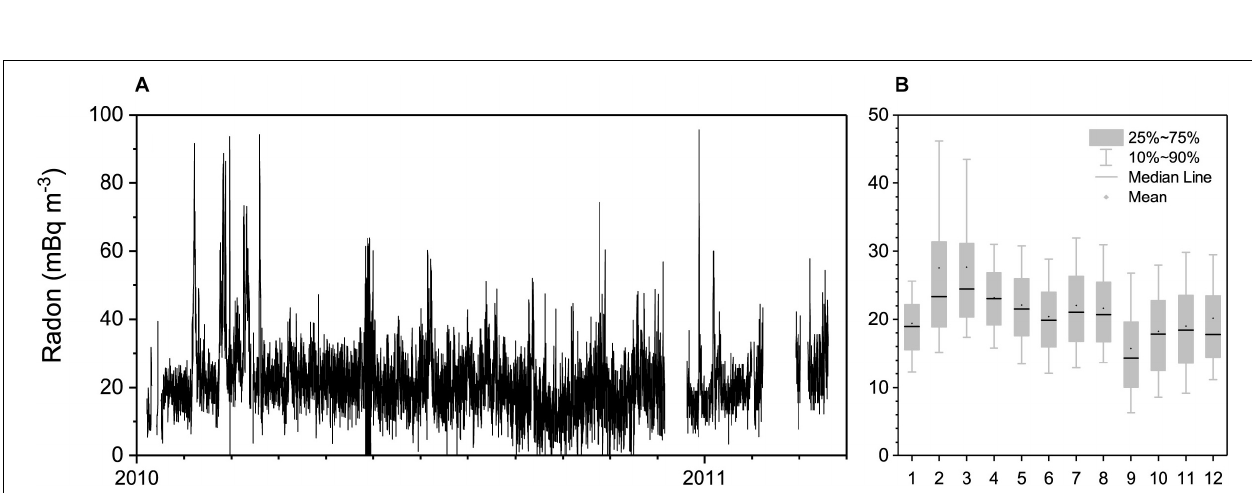
FIGURE 14 | (A) Hourly, and (B) monthly distributions of radon concentrations at Dome Concordia in 2010. Refer to key for distribution box-plot details.